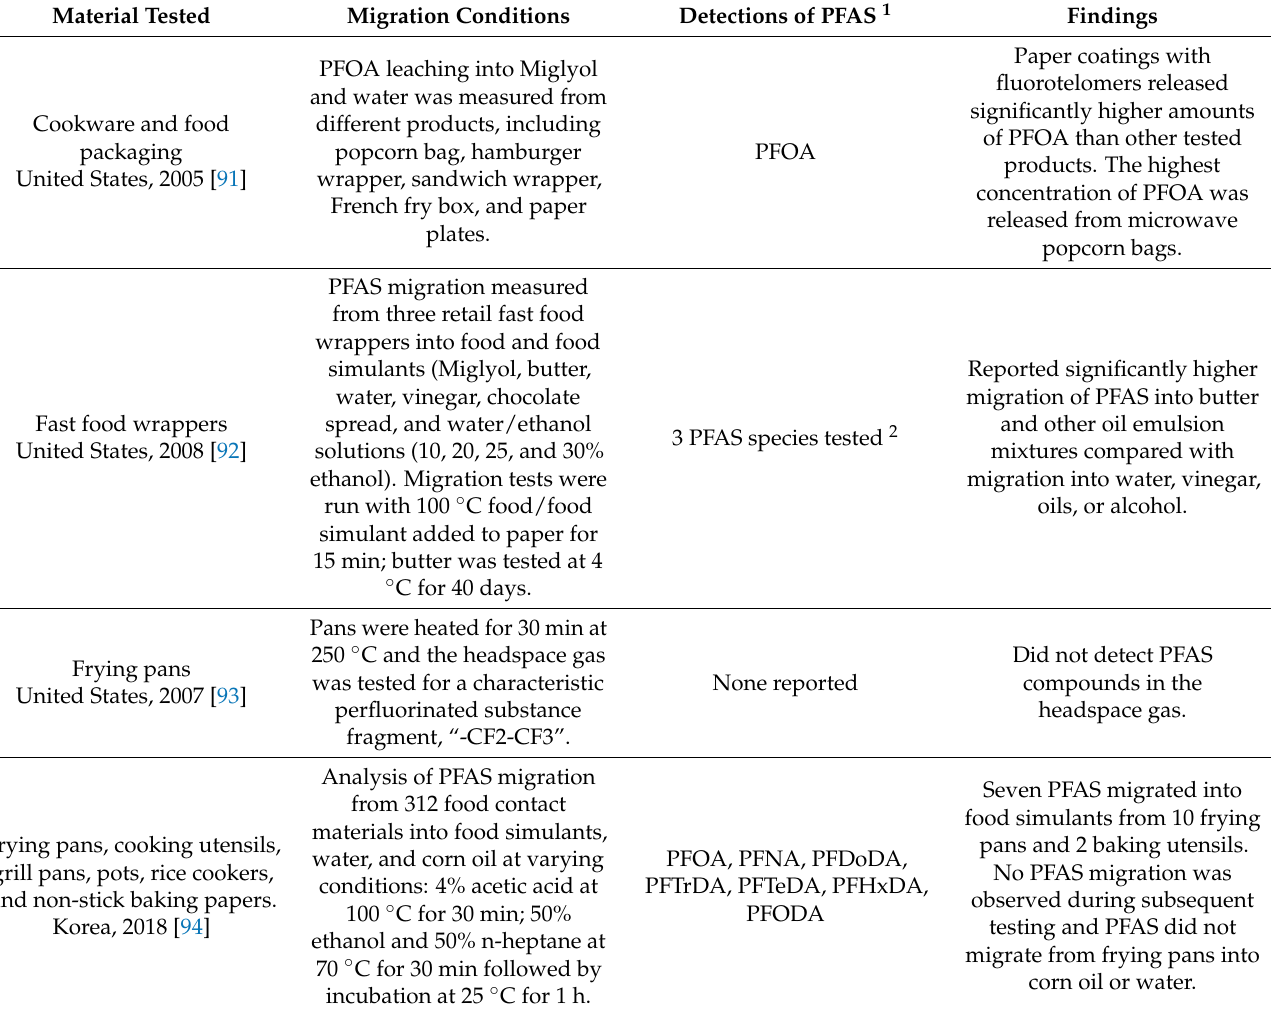
Table A1. Studies of PFAS migration from food contact